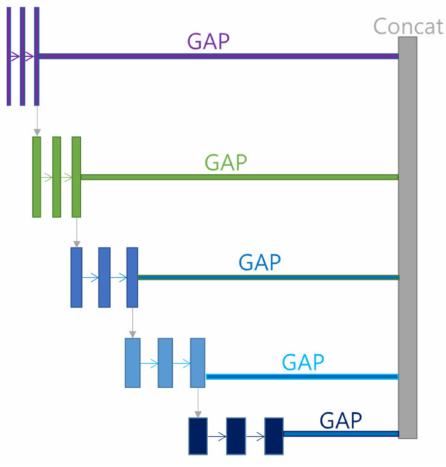
Figure 6. Encoder with Concat